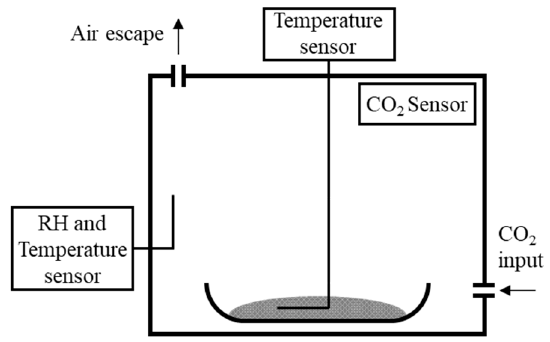
Figure 1. Equipment setup used in the carbonation test.